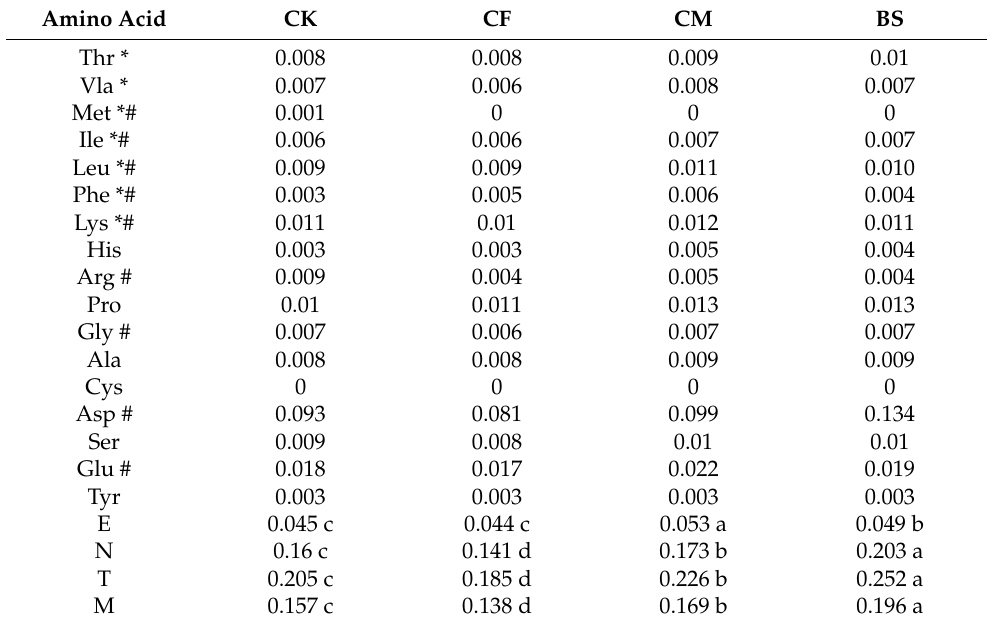
Table 4. The amino acids content (%) of in apple fruit under different fertilizer